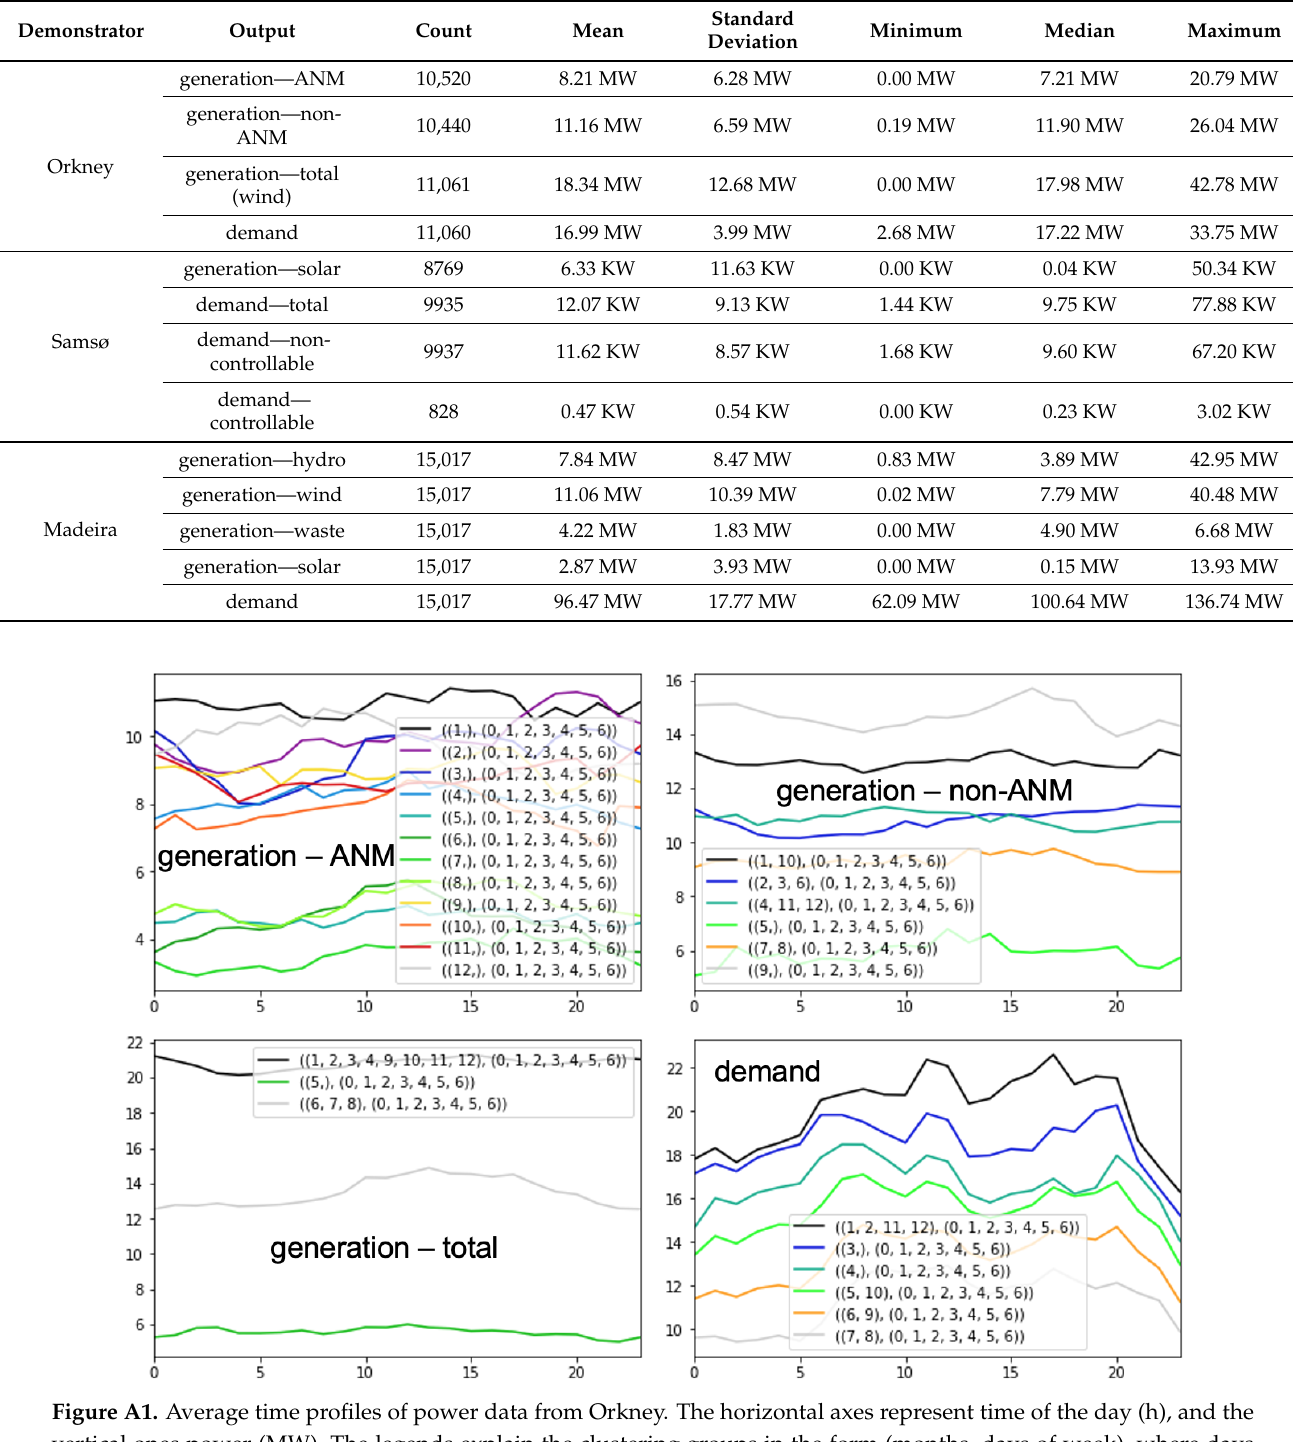
Table A1. Summary statistics of power data. Count is the number of timestamps when data exist, after resampling.